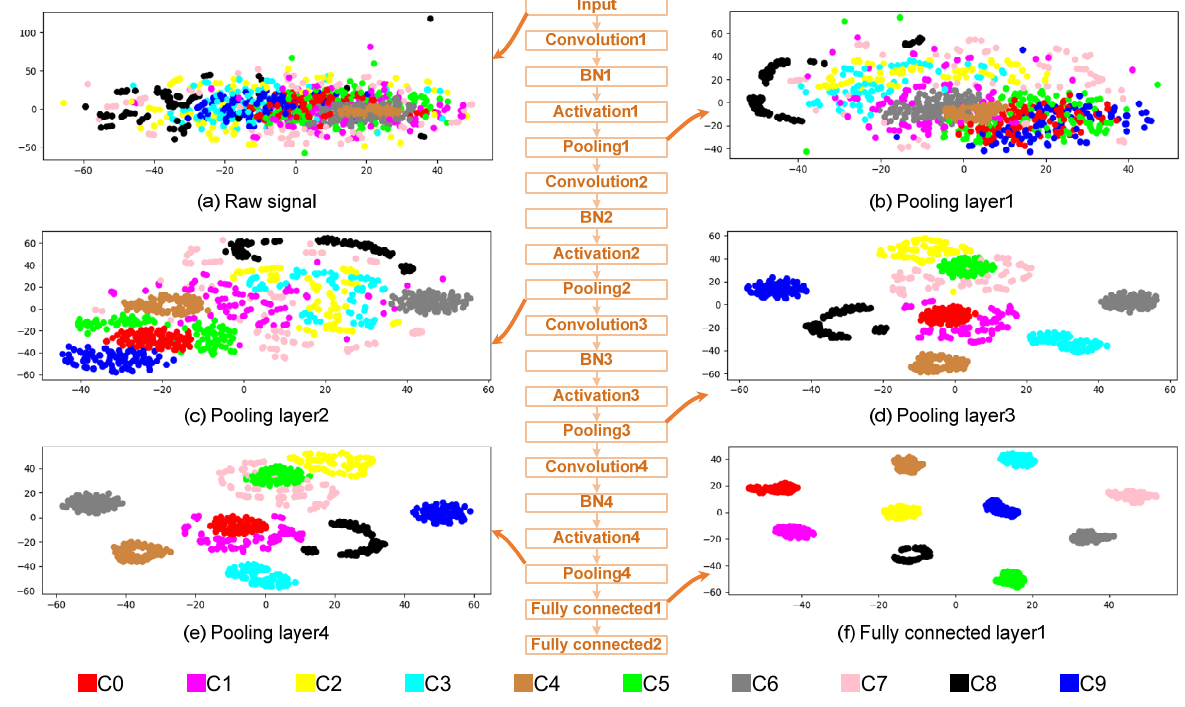
Figure 7. Visualization of features learned in different layers.